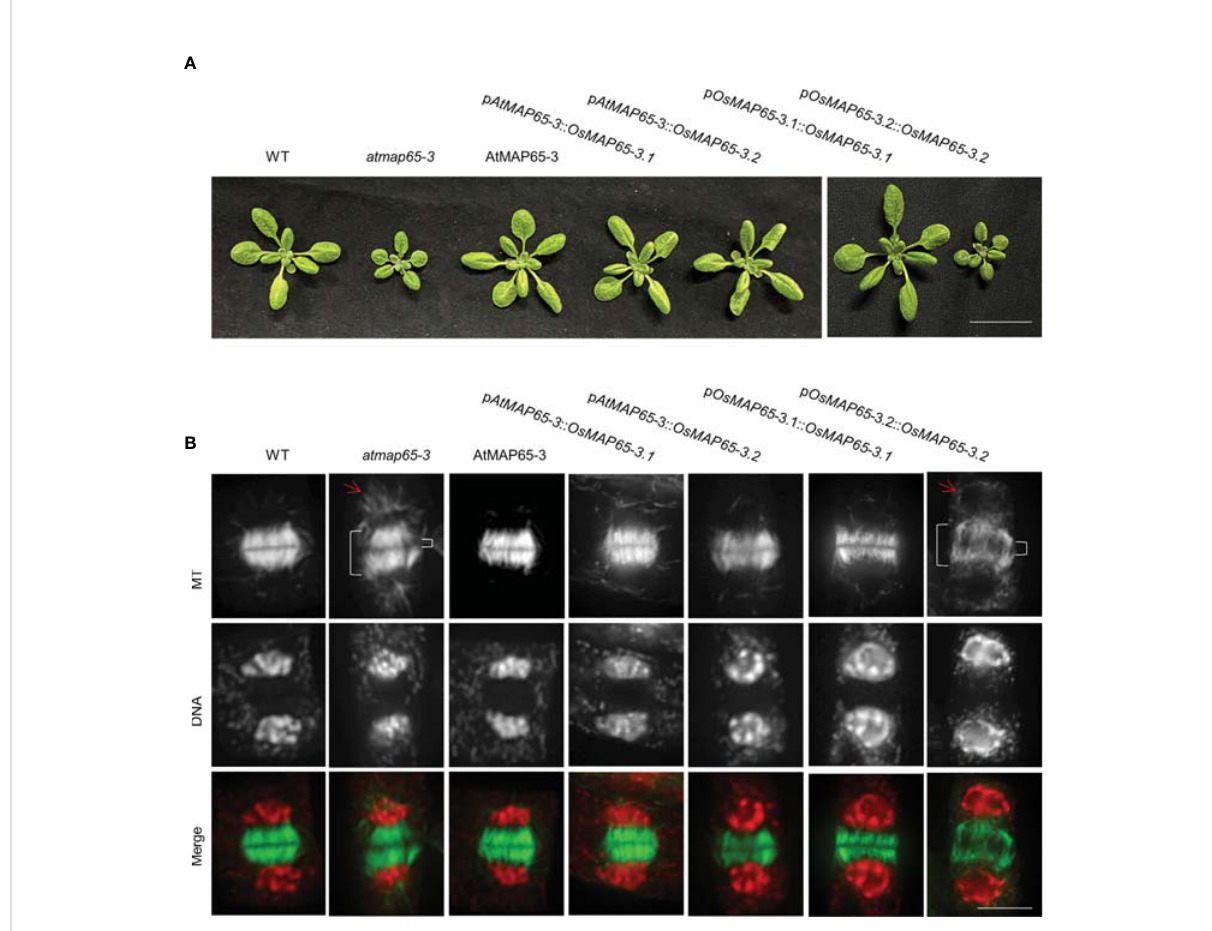
FIGURE 2 The effects of ectopic expression of OsMAP65-3.1 and OsMAP65-3.2 on suppression of the atmap65-3 phenotypes. (A) Growth phenotypes of 21-d-old seedlings and (B) developing phragmoplasts MTs of 14-d-old seedlings of the control wild-type, atmap65-3 , and transformants expressing the AtMAP65-3 , OsMAP65-3.1 and OsMAP65-3.2 proteins with AtMAP65-3 promoter or their own promoters in atmap65-3 background. The merged images have MTs in green and DNA in red. The bracket on the left represents the phragmoplast length and that on the right for the gap width, and arrows represents eminent MTs radiating from the two reforming daughter nuclei. Bar = 5 cm (A) and 5 um (B)